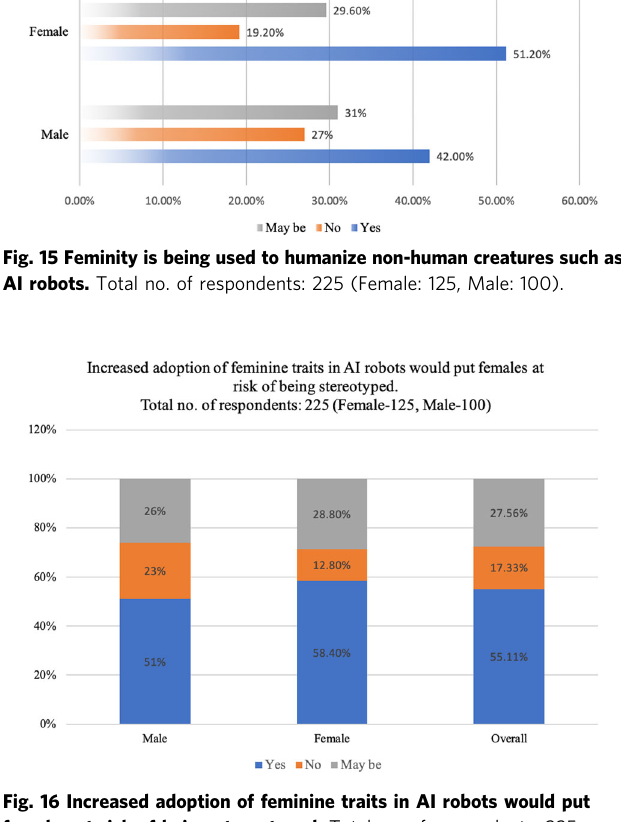
feel AI will have a stronger impact on both males and females.